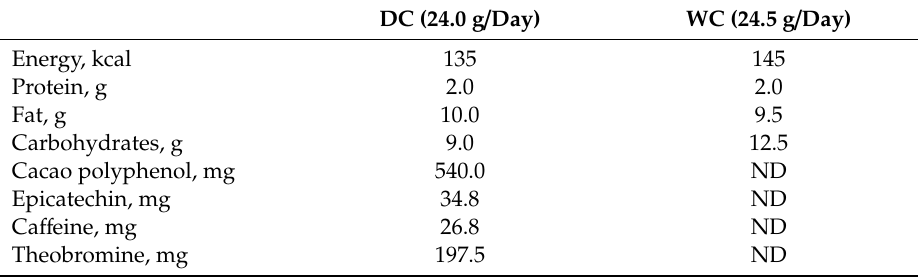
Table 1. Nutritional components of dark chocolate (DC) and white chocolate